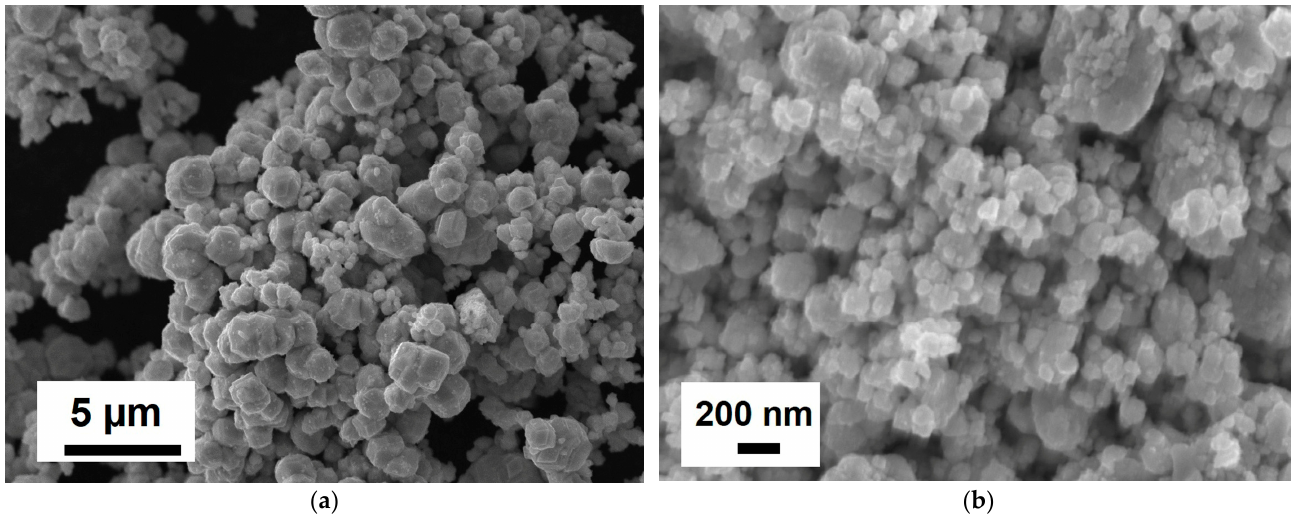
Figure 5. General view of initial tungsten powder ( a ) and composite granules ( b ). The general view of investigated tungsten materials: ( a ) tungsten initial powder (SEM NESCAN VEGA3); ( b ) composite granules (SEM Supra 50VP).